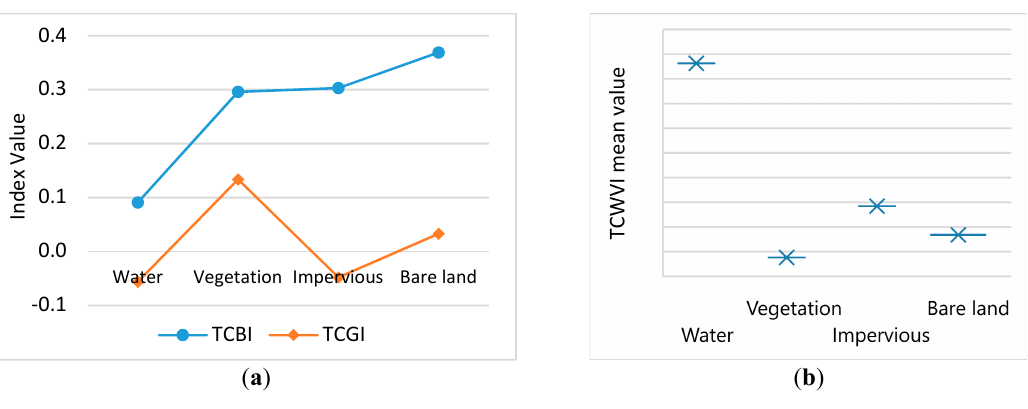
Figure 6. Building shadows in Hong Kong: ( a ) 30 meter Landsat-8 and ( b ) 5.8 meter ZY-3.